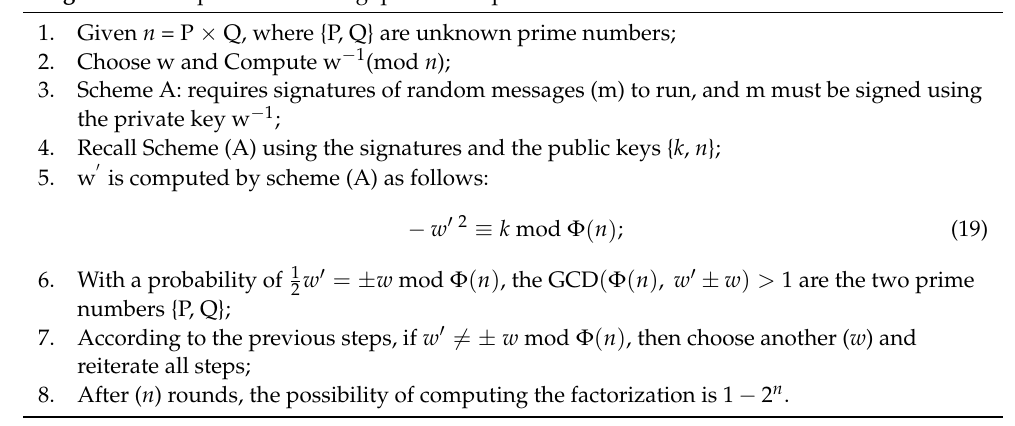
Algorithm 1 Steps for calculating quadratic equation